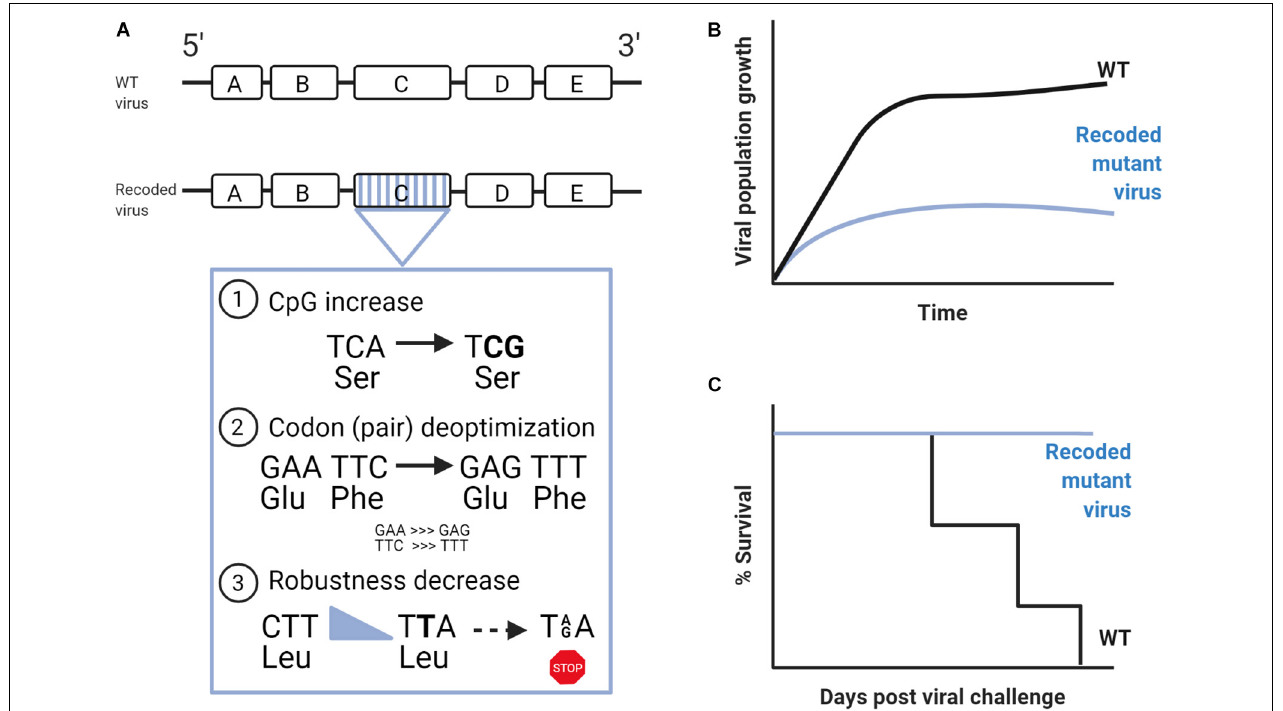
FIGURE 1 | Strategies to rationally attenuate viruses and develop live-attenuated vaccines. (A) Scheme of viral genomes; above is the wild-type (WT) genome, and below is indicated the recoded viral genomes by the main approaches used to attenuate viruses. (B) Viral population growth and (C) survival curves expected from a recoded virus and the WT.